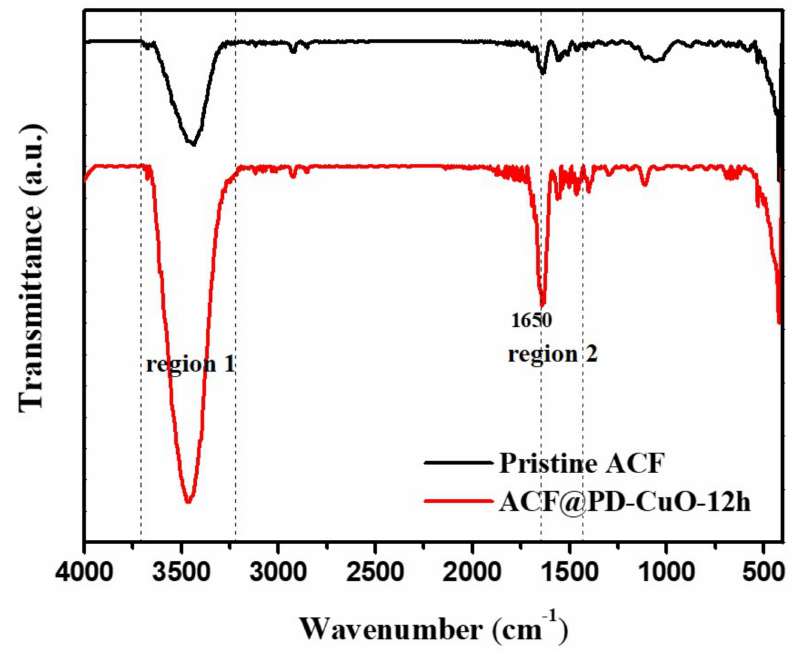
Figure 5. Fourier transform infrared (FTIR) spectra of pristine activated carbon fibers (ACF) and ACF@polydopamine-cupric oxide